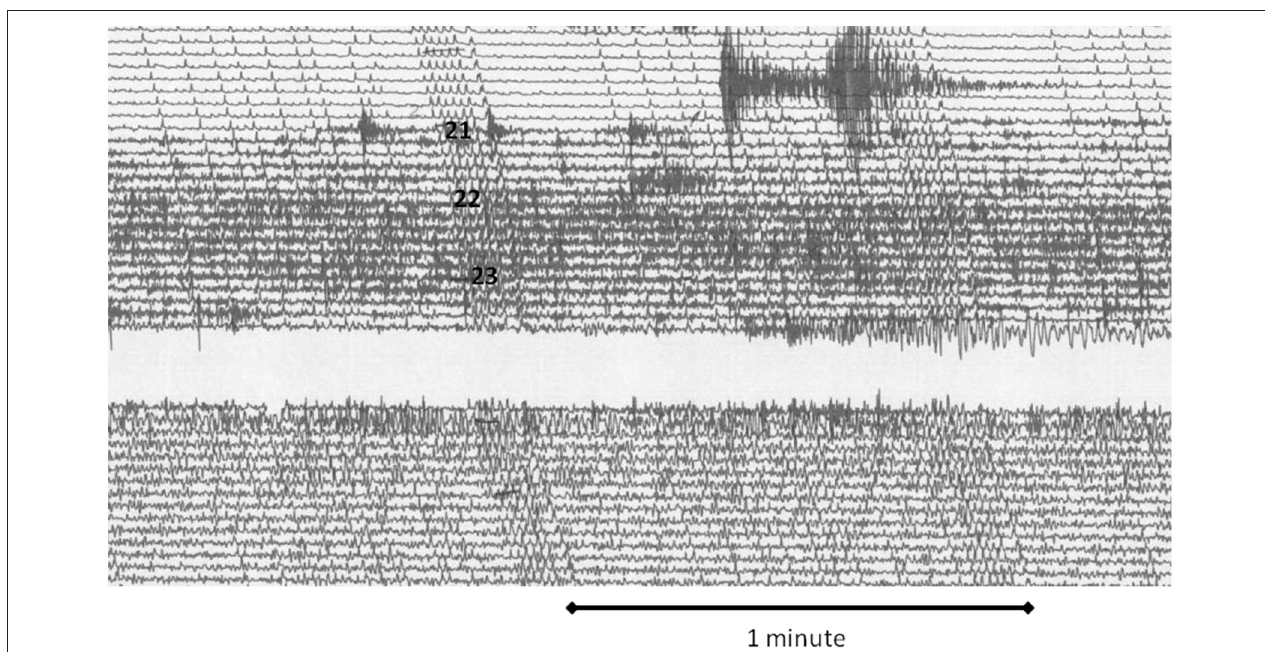
FIGURE 4 | The beginning of the September 1984 Krafla eruption seen at the seismic station of Skinnastaður, 40km north of the eruption site. Only a section of the seismogram is shown. The earthquake near the top of the seismogram was a magnitude 2.9 (M τ ) event in the Tjörnes fracture zone in Fljót, unrelated to the eruption. At this station high-frequency tremor mixed with earthquakes is seen at 22:50. The beginning of the eruption at 23:49 is not accompanied by a significant seismic event. The eruption was accompanied by low-frequency tremor, but very few